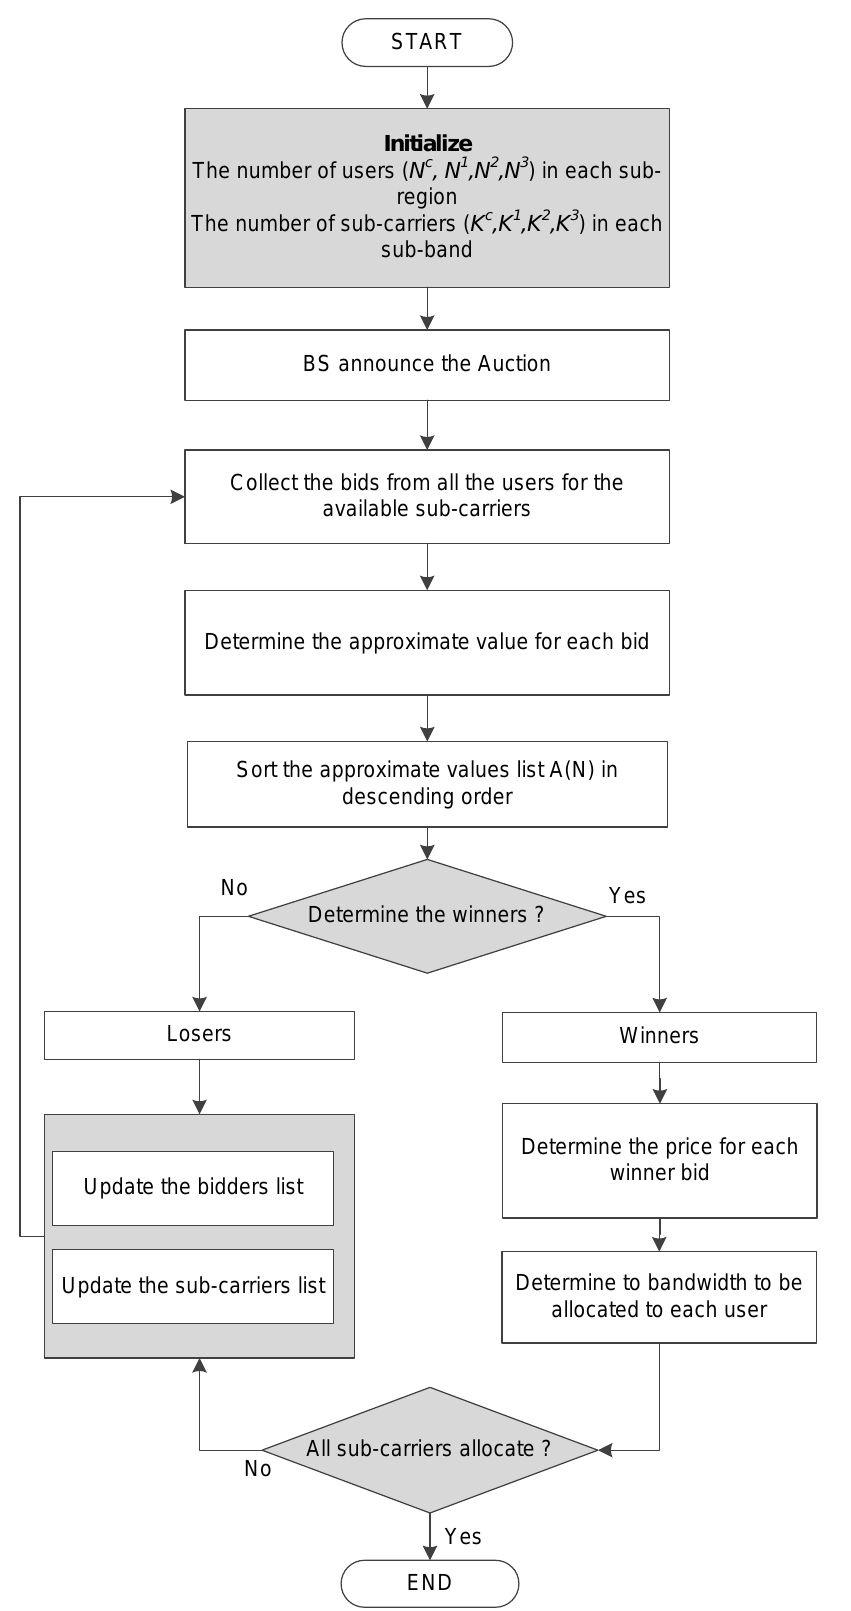
Figure 3. Detailed flow-chart of AMS-FFR